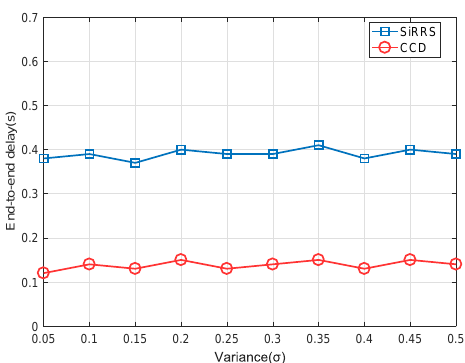
Figure 11. End-to-end delay of light data load.